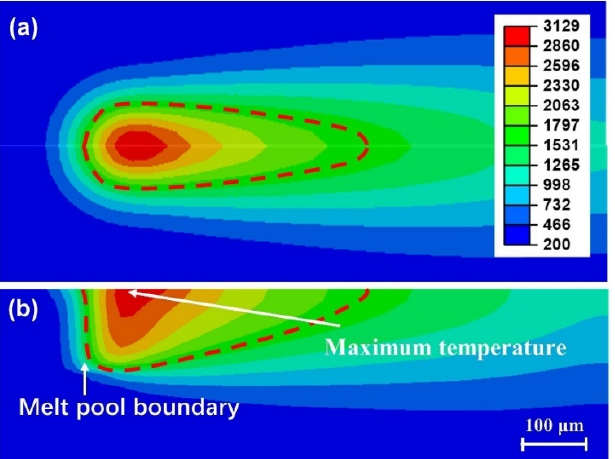
Figure 7. Melt pool temperature contours simulated with a laser power of 400 W and scanning speed of 1400 mm/s: ( a ) horizontal cross-section; ( b ) longitudinal cross-section.